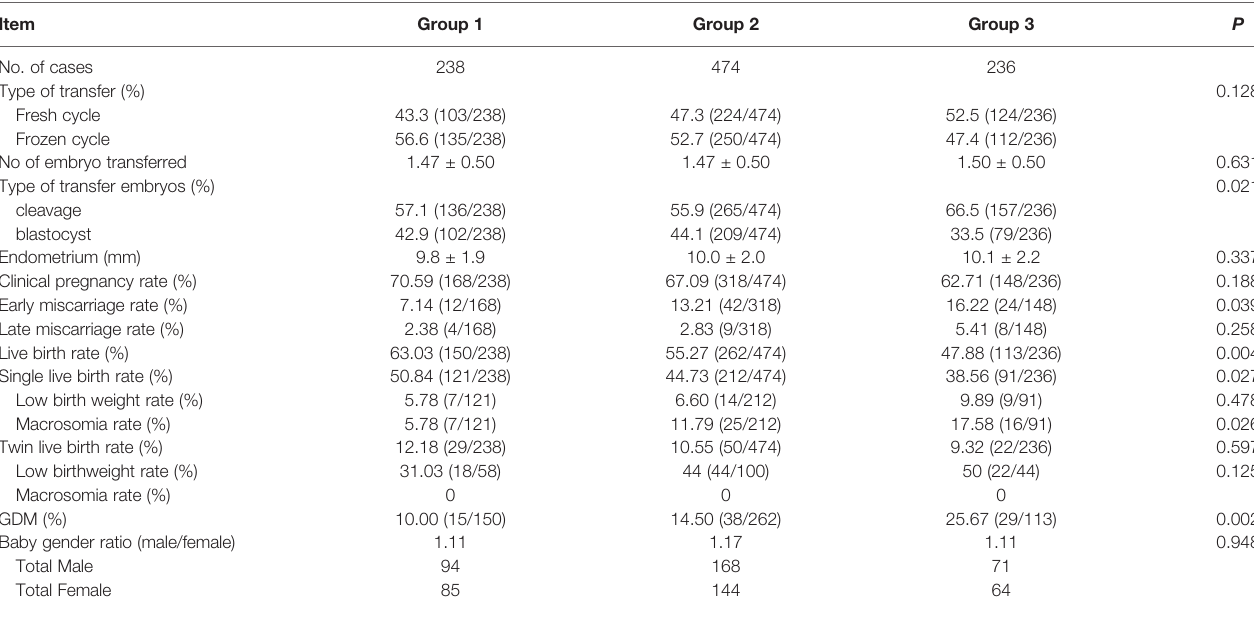
TABLE 3 | Outcomes of fi rst embryo transfer cycle.